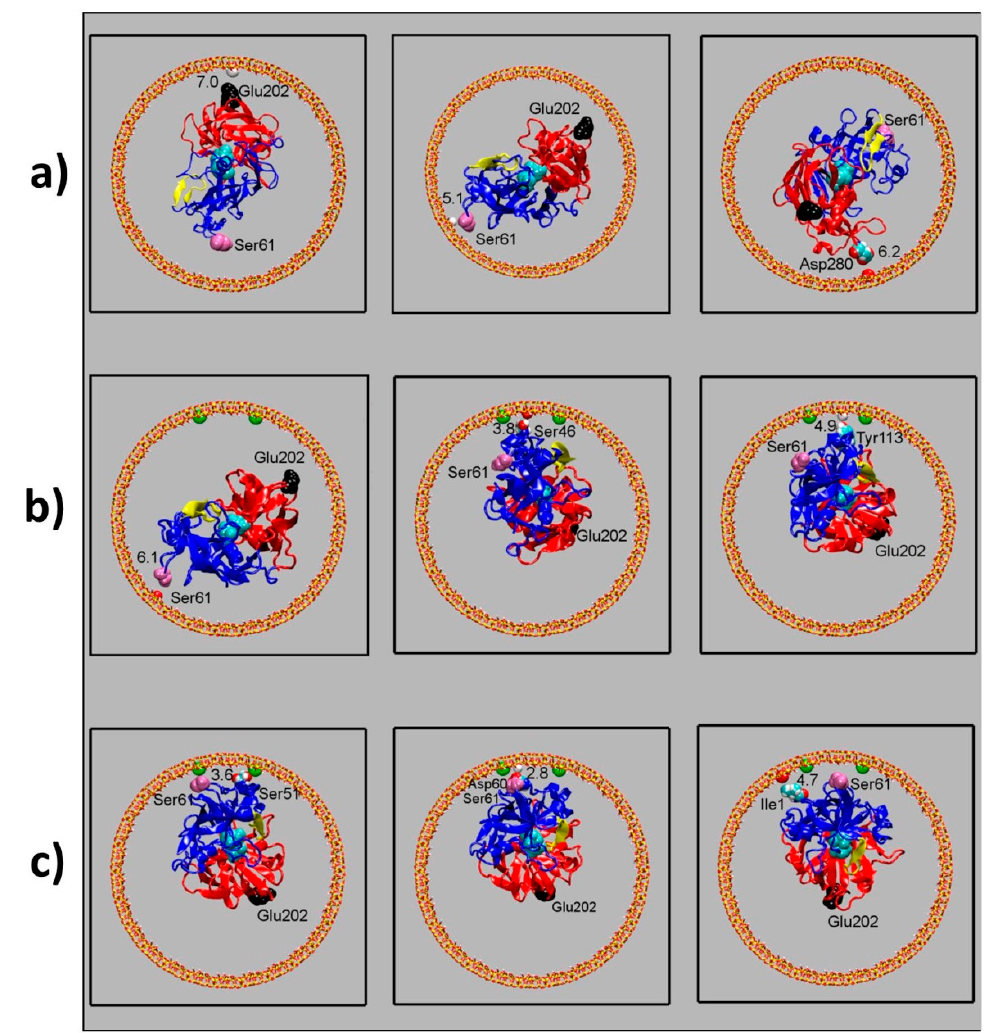
Figure 6. Snapshots representing different orientations of pepsin with respect to the surface. ( a ): simulation with the neutral channel (Model 1). ( b ): simulation with a negatively charged channel (Model 2). ( c ): simulation with a negatively charged silica channel and a smaller nanodroplet (Model 3). The mesopore (xy plane) is shown in stick representation; color: yellow for Si atoms, red for oxygen atoms and white for hydrogen atoms. The two pepsin domains are shown in red and blue respectively. The catalytic site is represented as cyan spheres, the flap region as a yellow ribbon. Ser61 (pink spheres) and Glu202 (black spheres) are the pepsin residues separated by the largest distance. The distance from the surface of the closest protein residue is reported for each configuration (in Å).